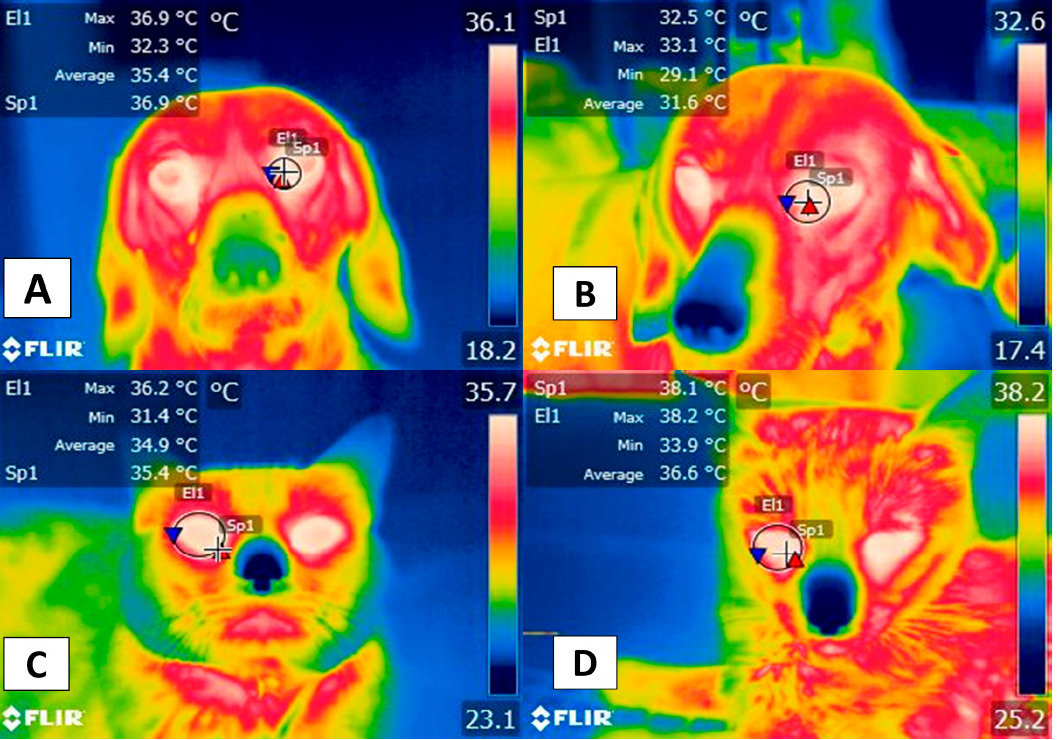
Figure 3. Facial thermal windows in the dog and cat: ( A ) Lacrimal caruncle. The lacrimal caruncle (El1) is shown in the eye region of a 4-year-old dog prior to surgery. This area runs from the medial commissure of the eyelid to the mid-region of the eye. Additionally shown is the temperature of a dog at rest. The maximum temperature was 36.9 °C (red triangle), the minimum was 32.3 °C (blue triangle). ( B ) Lacrimal caruncle (El1). This image shows modifications in the same dog after 2 h of concluding the surgical procedure with a decrease of 3.8 °C from the maximum (33.1 °C, red triangle) and 3.2 °C from the minimum (29.1 °C, blue triangle) generated by the perception of pain during the surgical procedure that activated the ANS, causing a reaction that consisted of peripheral vasoconstriction with a decrease in surface circulation that reduced the irradiated temperature. This would explain the thermal reaction observed. ( C ) Ocular region. Image showing the ocular thermal window (El1) of a 4-year-old feline wounded by the attack of a conspecific. This thermal window covers the entire interior zone of the eyeball. The maximum ocular temperature recorded was 37.3 °C (red triangle), the minimum was 33.9 °C (blue triangle) while the animal was comfortable or at rest. ( D ) There is an increase of 0.9 °C in the maximum temperature (38.2 °C, red triangle) due to peripheral vasodilation. This vasomotor response is a consequence of proinflammatory mediators (e.g., histamine) released after the injury. Sp1: default focal point of the software. Thermal images obtained using a FLIR thermal camera.